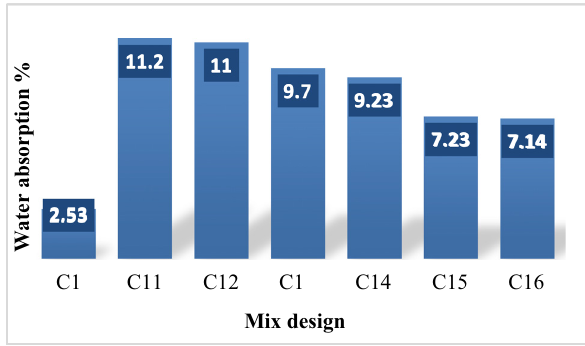
Figure 7: Water absorption for concrete mixes at 28